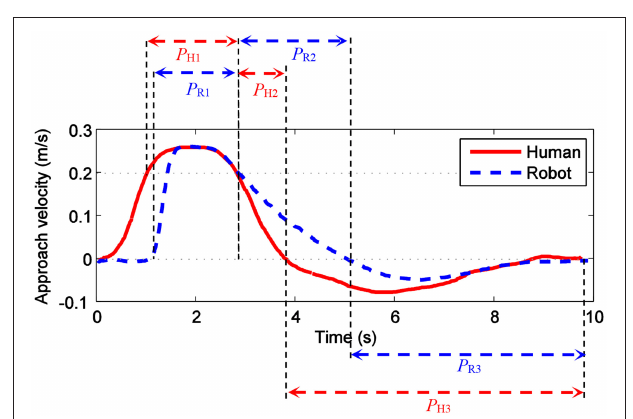
line is the human movement trajectory. The dashed line is the robot’s new path. To start with, the human approached the robot fast and the system detected that the approaching speed of the human was more than v H _ danger , then the robot made a judgment to avoid the human directly. Figure 6 shows that the avoidance the human. A bounding sphere was calculated by the system, in order to plan a new path for the robot, when the human slowed